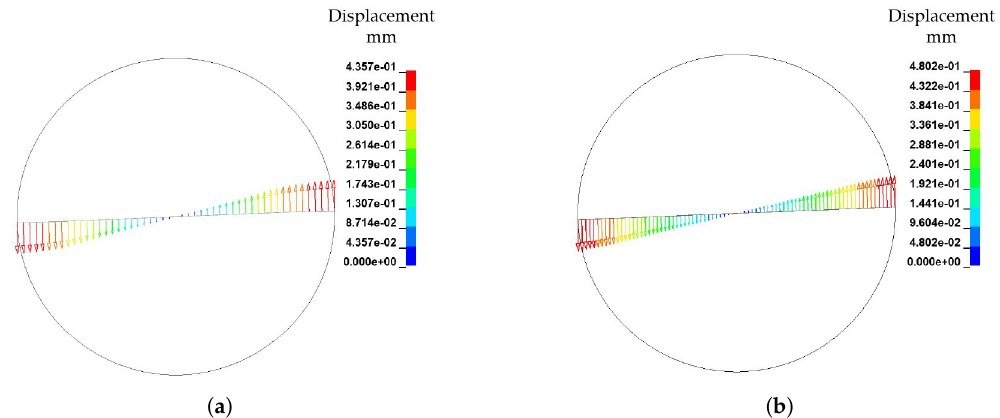
Figure 24. Comparison of fibre displacement and deformation by different mesh fineness. ( a ) Mesh size = 1mm. ( b ) Mesh size =